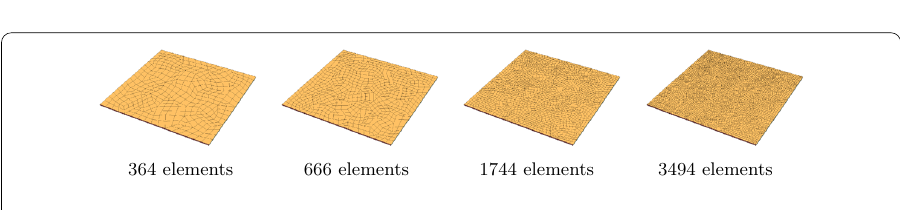
Fig. 10 Clamped plate: refined unstructured